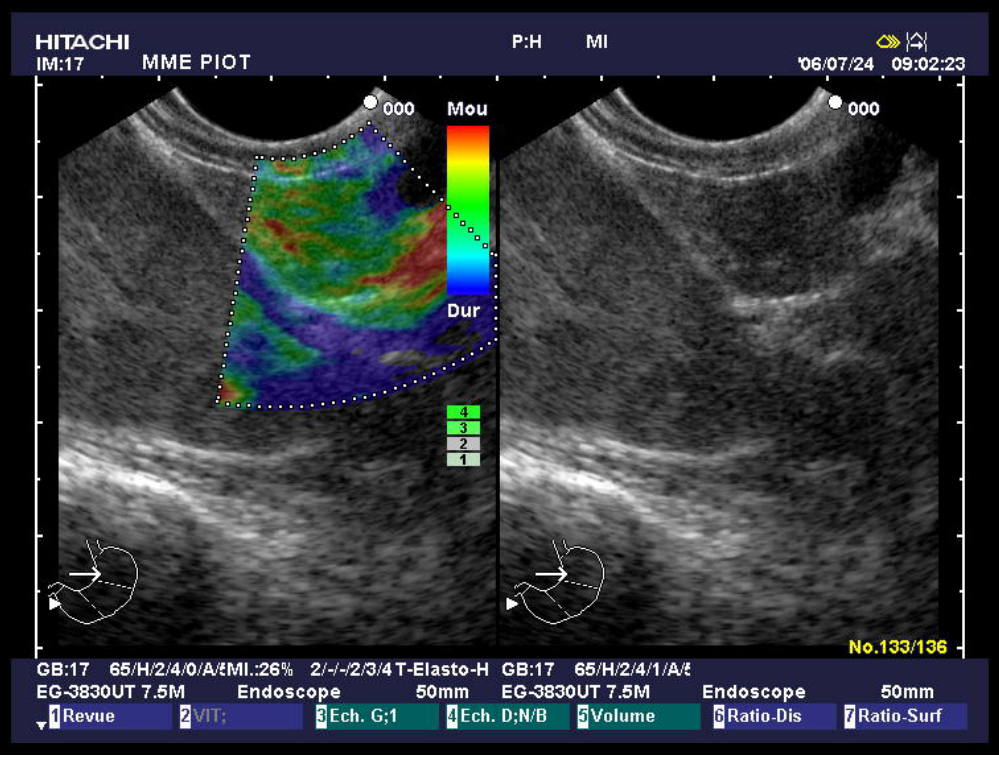
FIGURE 12. Score 2: nodule of chronic pancreatitis.